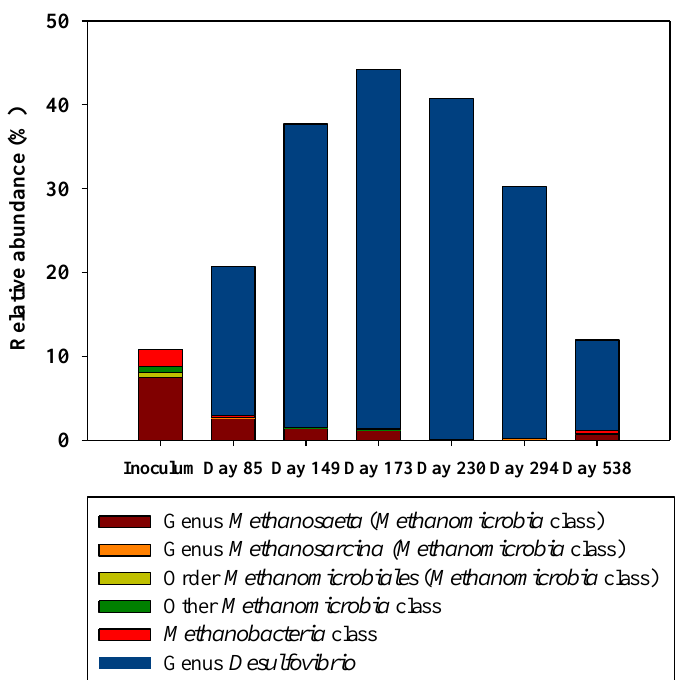
Figure 4. Relative abundances (%) of all the methanogens detected in all the samples together with the main sulfate reducer (genus Desulfovibrio ).